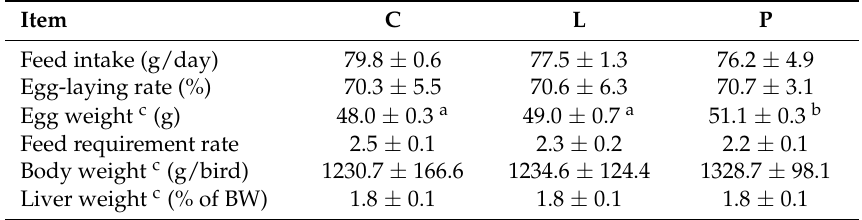
Table 5. Feed intake and production parameters of laying hens ( n =